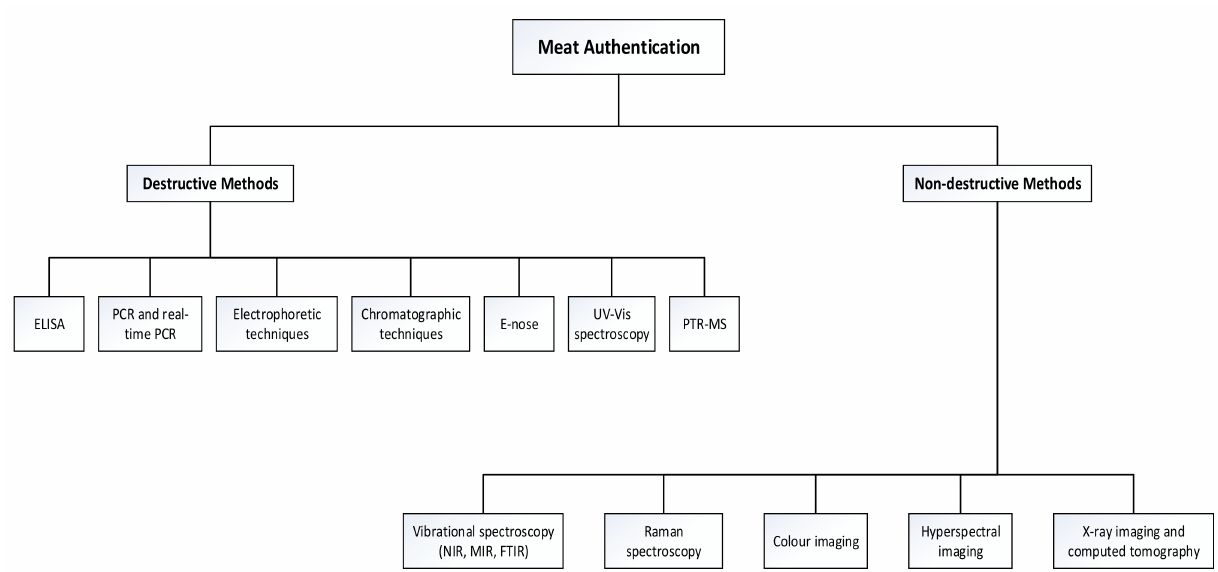
Figure 1. Schematic of the destructive and non-destructive methods used for meat